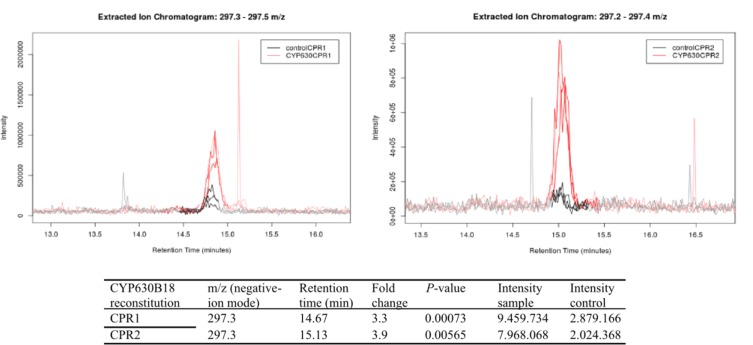
Oleic acid oxidation by GsCYP630B18 in combination with GsCPR1 or GsCPR2.Extracted ion chromatograms (297.2–297.4 m/z, run in negative-ion ESI-MS) for oleic acid conversion by GsCYP630B18 in combination with GsCPR1 or GsCPR2 with the highest peak (m/z 297.3) identified as 18-hydroxyoleic acid. Darkened lines indicate where the peaks were integrated for relative ion intensity comparison. Samples GsCYP630 with GsCPR1 (top left panel) and GsCYP630 with GsCPR2 (top right panel) are shown in red. Controls (empty E. coli membrane fractions with GsCPR1or GsCPR2) are shown in black. Significant differences for the major product peak between controls and samples were indicated by P-value (P < 0.05, n = 3). Additional data for each analysis are shown below the LC/MS traces as m/z value, retention time, fold change as ratio of mean intensities between samples and controls, P-value, and peak intensity as average feature intensity within sample/control class.